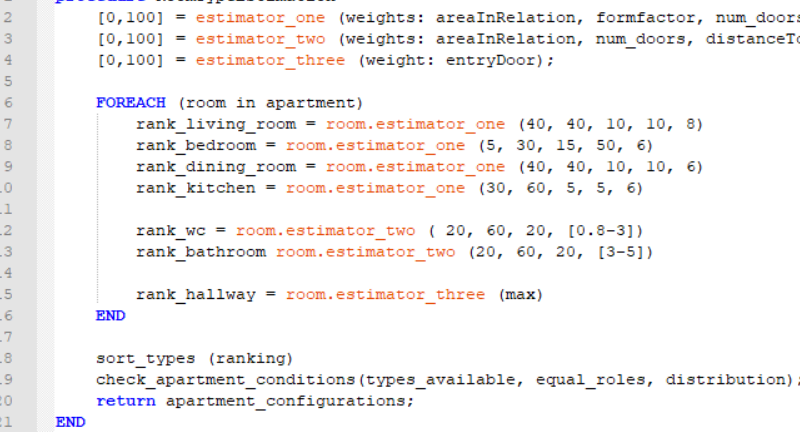
Figure 15. The concept of the room type estimation algorithm.